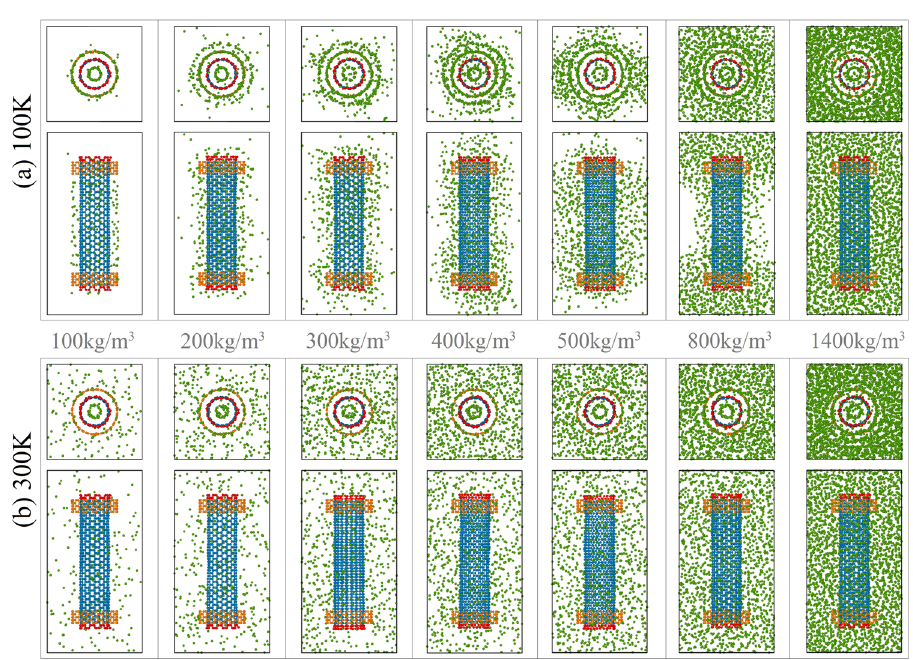
Figure 5. Representative configurations of the system in which the rotor is in a stable rotation state in argon environments at different temperatures. ( a ) At 100 K, the argon density is between [100, 1400] kg/m 3 , ( b ) at 300 K. In the system is the “ N = 2”